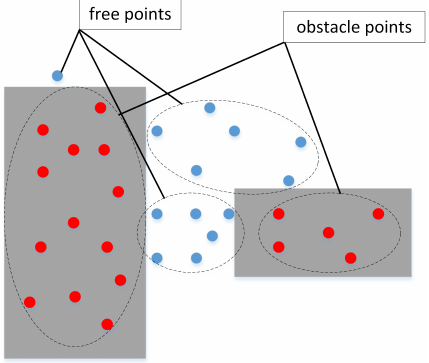
Figure 6. Typical classification of sampling points.